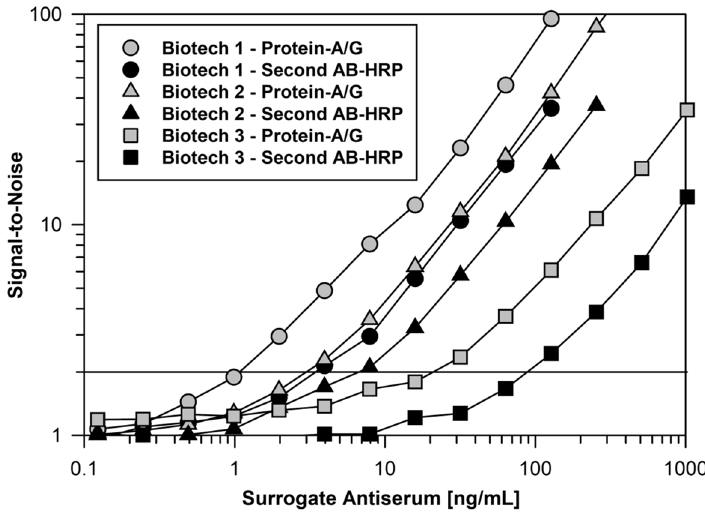
Figure 5. Comparison of serum immunoglobulin detection by optimized assay using SULFO-TAG labeled Protein-A/G versus conventional ELISA with horseradish peroxidase. MSD plates were coated overnight at 4 °C with 2 µg/mL of 3 different biotherapeutics. On the following day, the plates were washed and blocked with ChonBlock. Standard curves of surrogate MAbs specific to the various biotherapeutics were prepared in human serum and then diluted 1/100 in ChonBlock. The remainder of the assay was performed as described in the “Materials and methods” section using detection with 0.1 µg/mL of SULFO-TAG labeled Protein-A/G or a 10,000-fold dilution of HRP labeled Protein-A/G diluted in LowCross Buffer. For all three surrogate antibodies, the response ratios were appreciably greater when SULFO-TAG labeled Protein-A/G was used as the detection reagent with 2-times background responses occurring at about 1, 3, and 20 ng/mL,